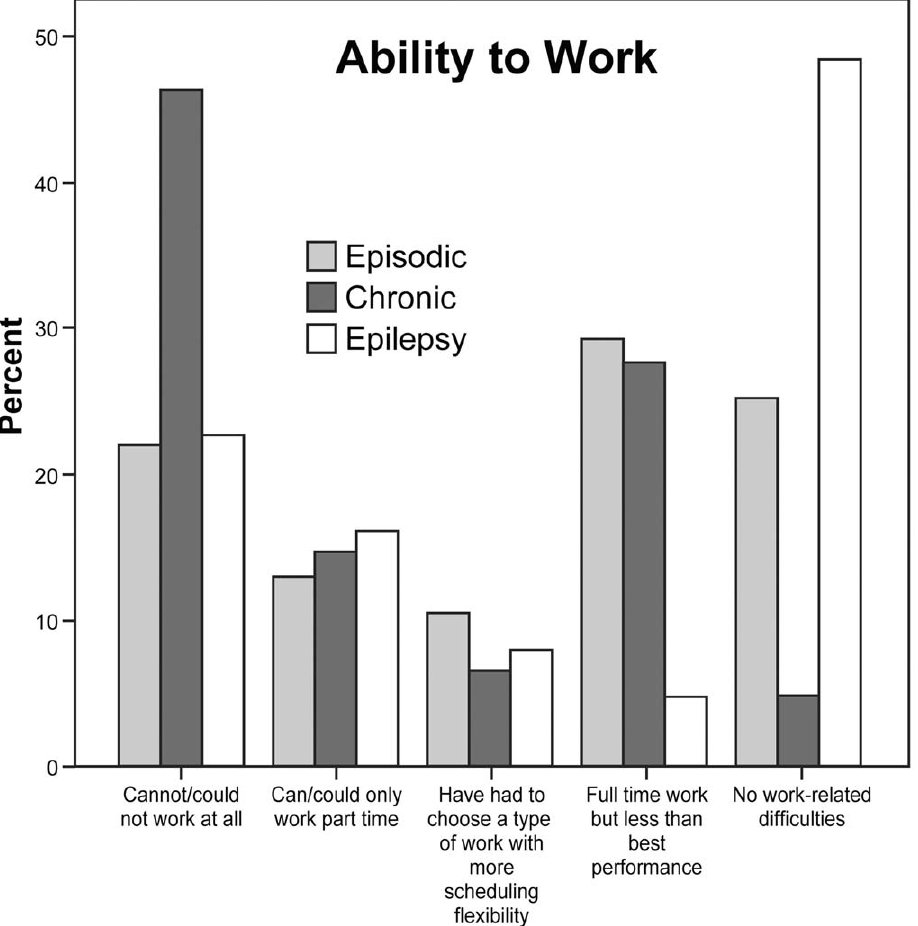
Figure 1. Effect on Work. Results of questionnaire in which subjects were asked about whether they could work. If they were not working and not trying to work they were asked to imagine trying to work with their current headache or epilepsy condition. Chronic migraine had worse ability to function.